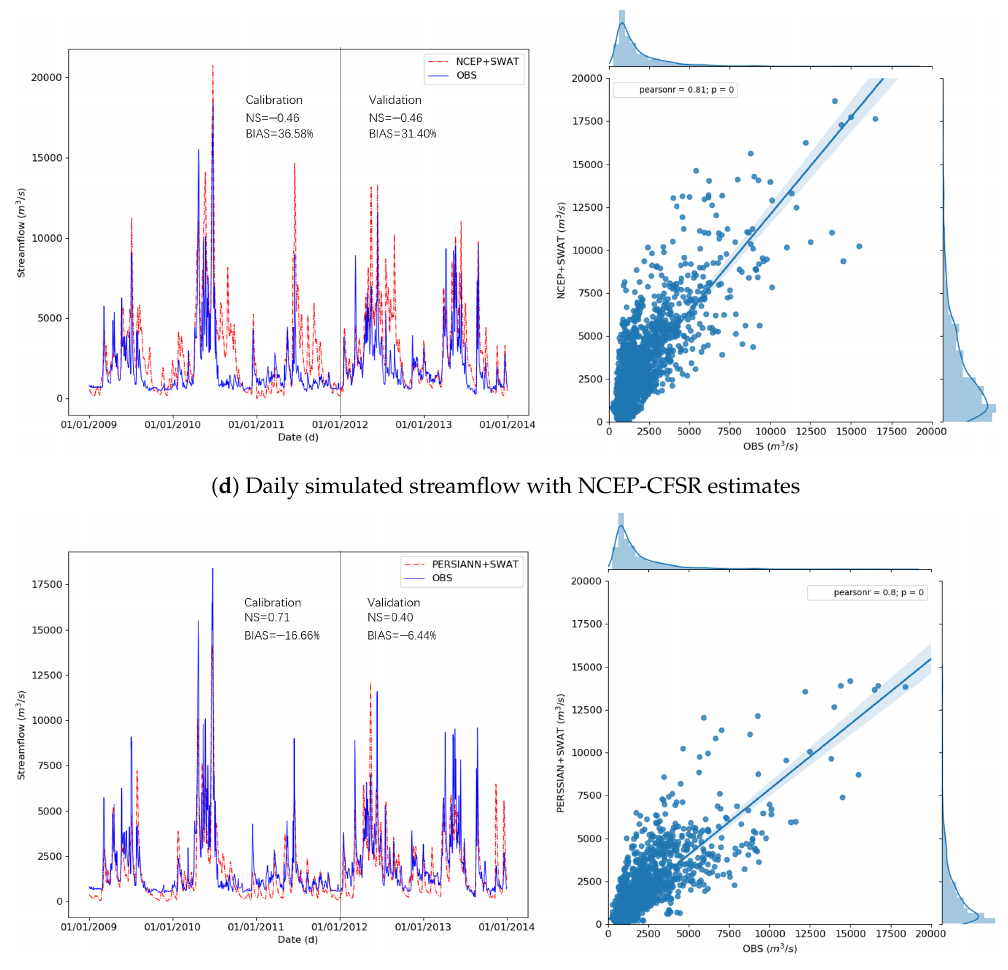
Figure 7. Daily simulated flow in Xiangtan station with precipitation from gauge ( a ), PERSIANN-CDR ( b ), NCEP-CFSR ( c ), CMADS ( d ), and 3B42V7 ( e ) (In the scatter plot, pearsonr represents Pearson’s correlation coefficient, p represents the significance of paired t-test, and the shade represents the 0.95 confidence interval).